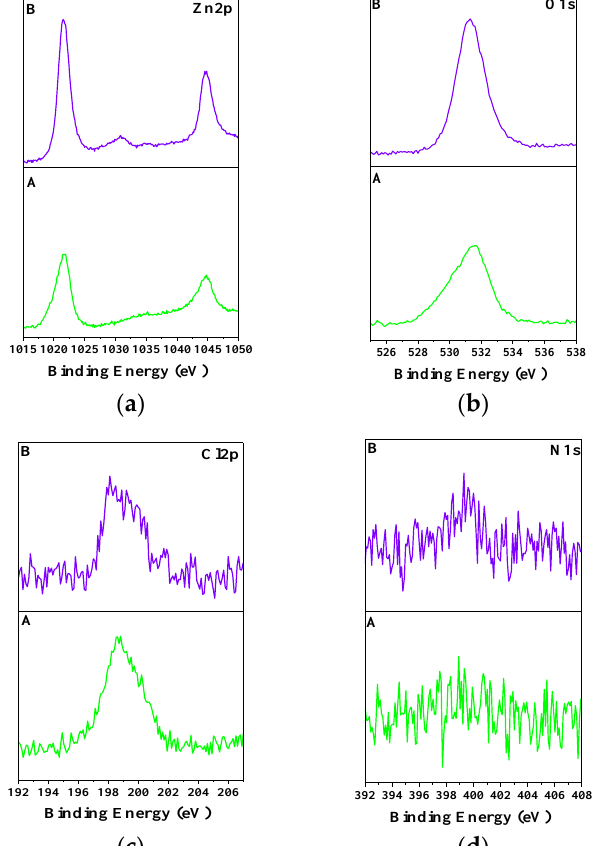
Figure 7. XPS spectra of corrosive untreated and corrosive treated Zn-PANI/SiO 2 coating. ( a ) — Zn 2 p ; (b) — O 1 s ; (c) — Cl 2 p ; (d) — N 1 s . A — corrosive untreated; B — corrosive treated.